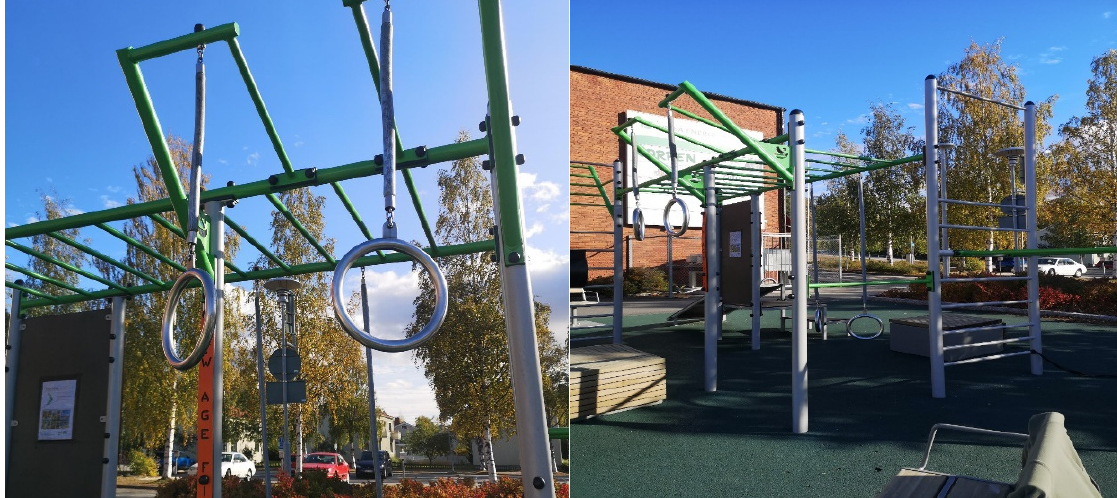
Figure 1. Pictures of an outdoor gym in Umeå, Sweden.